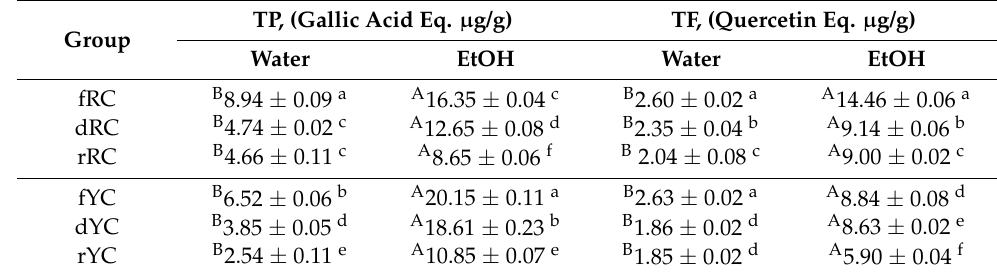
Table 7. Variation of total phenolic and flavonoid pattern in differently treated polymorphic cacao beans